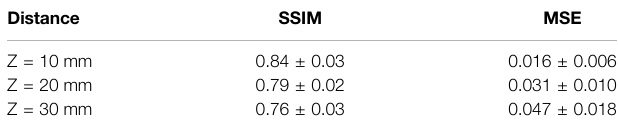
TABLE 1 | Quantitative results of acoustic hologram reconstruction at different diffraction distances (z = 10 mm, z = 20 mm, and z = 30 mm). For each distance, 100 independent trials are used and